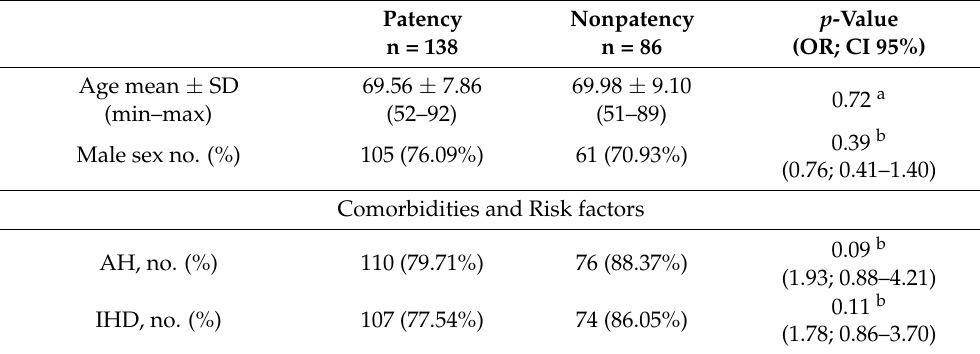
Table 3. Demographic data, comorbidities, risk factors, and laboratory findings of the two subgroups were evaluated according to patency of performed